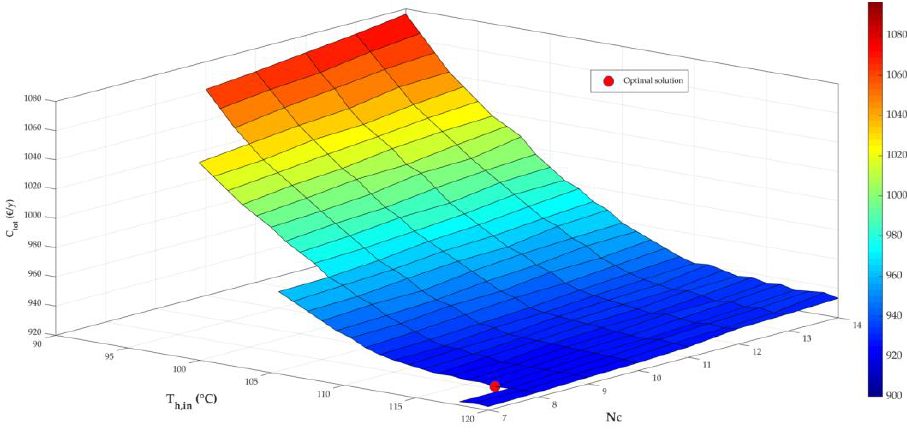
Figure 11. Total exergoeconomic cost minimization.